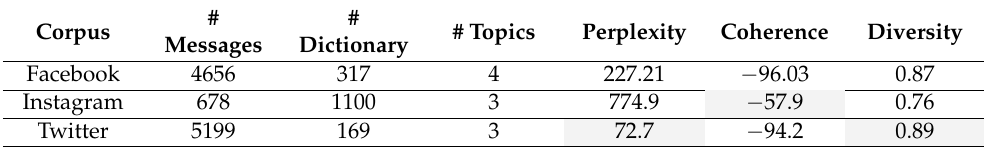
Table 1. Measures of perplexity, coherence and diversity for each sub-corpus.